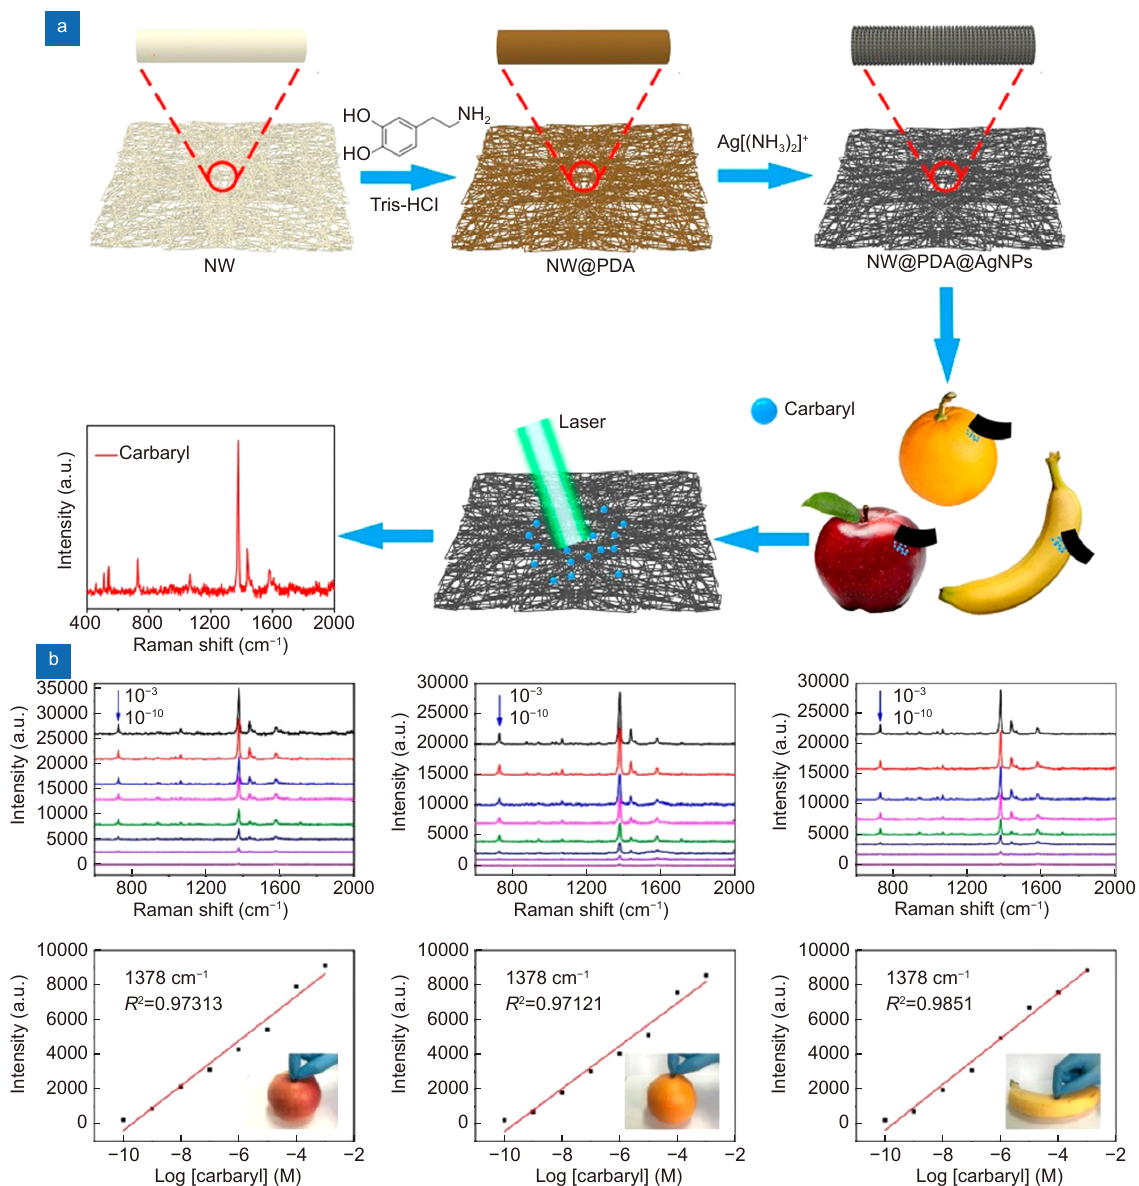
Fig. 11 | ( a ) Schematic of flexible non-woven fabric based substrate and the ( b ) SERS spectra of carbyl on apples, oranges, and bananas sur- faces. Figure reproduced with permission from ref. 129 , under a Creative Commons Attribution 4.0 International